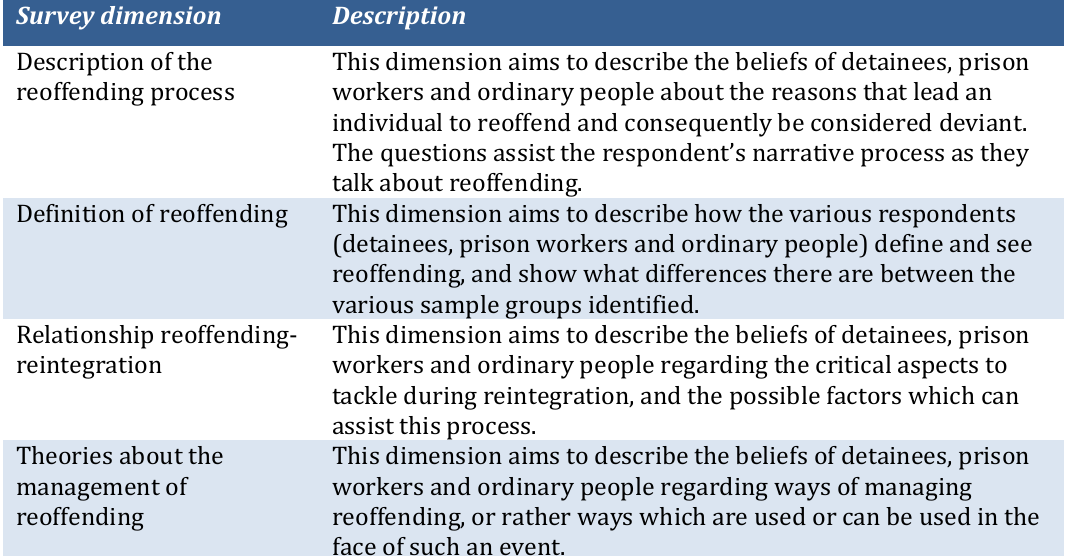
Table 1: Description of survey areas Survey